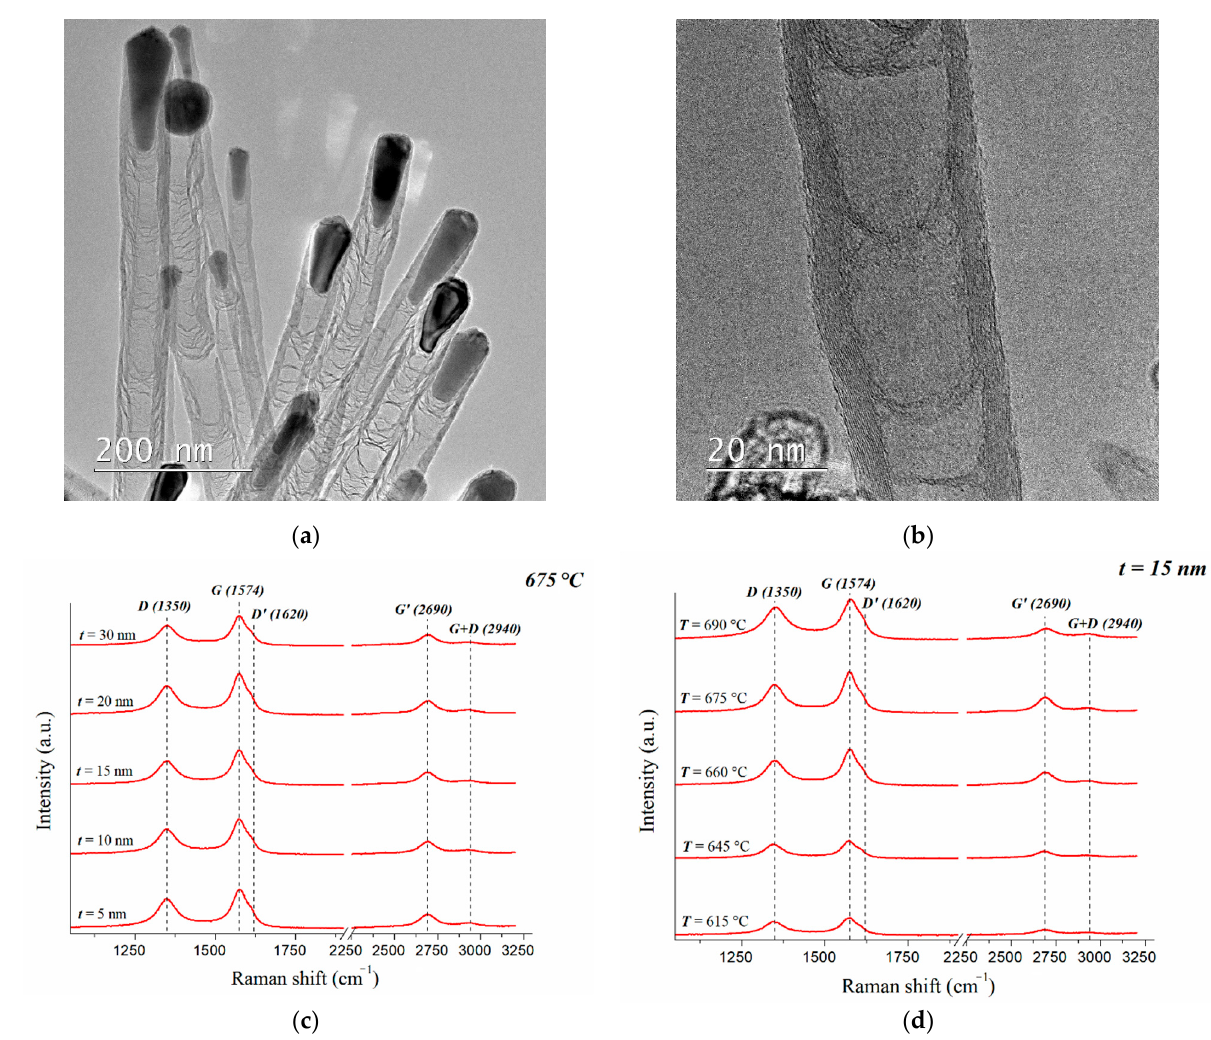
Figure 2. TEM images of the studied CNTs ( а , b ). Raman spectra of CNT arrays grown at a temperature of 675 °C and a catalytic layer thickness of 5 to 30 nm ( c ), and at a catalytic layer thickness of 15 nm with an increase in temperature from 615 to 690 °C ( d ).